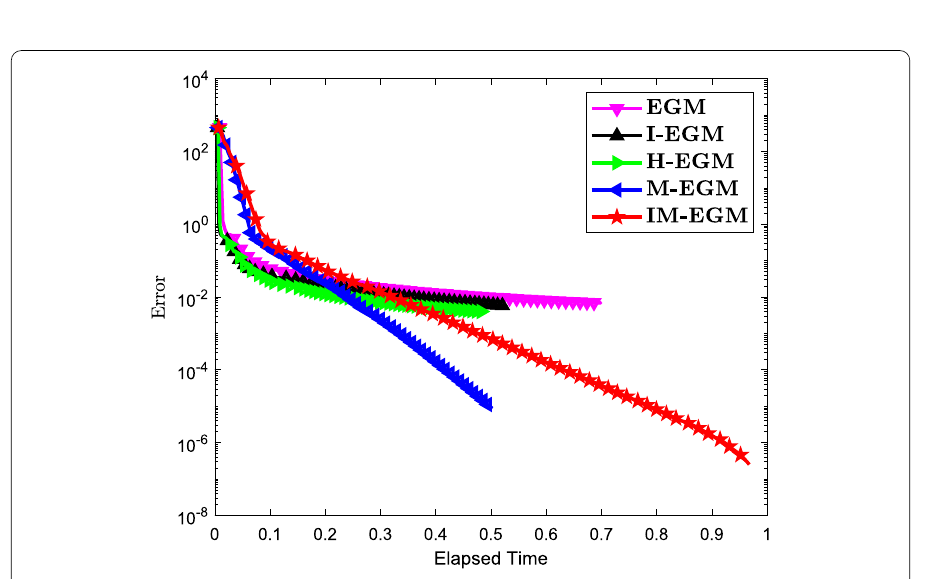
Figure 12 Numerical comparison of Algorithm 1 and Algorithm 2 using Algorithm 1 in [52], Algorithm 2 in [51], and Algorithm 1 in [18], while s 0 = s 1 = t for the first 500